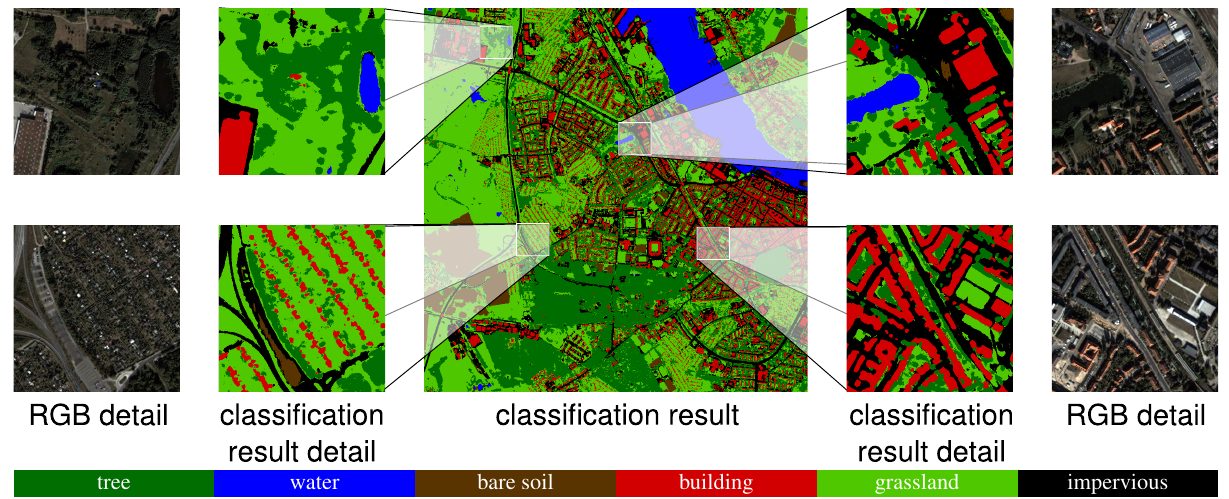
Figure 5: Classification result and four sample areas in full resolution (each 420 × 420m ).